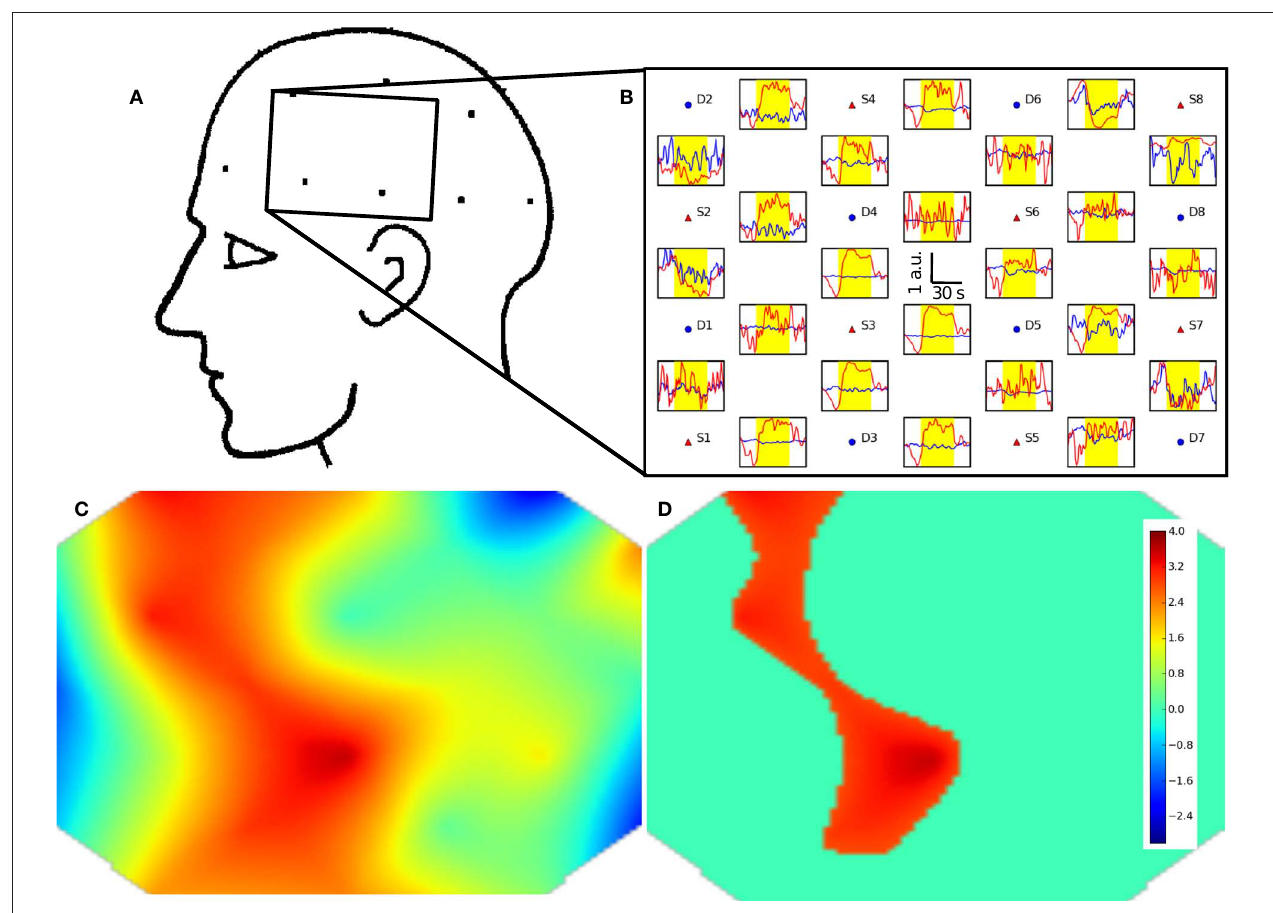
shown in arbitrary units (relative concentration), due to an unknown scattering factor. (C) Example NIN image of task-related oxy-hemoglobin regression parameter Z -scores from (B) corresponding to the rectangular area shown in (A) . (D) The same data as (C) , masked at a statistical threshold of p < 0.05 corrected for multiple comparisons. Color bar for Z -scores in both (C) and (D) appears in (D) . Plots B–D were made with NinDISP using